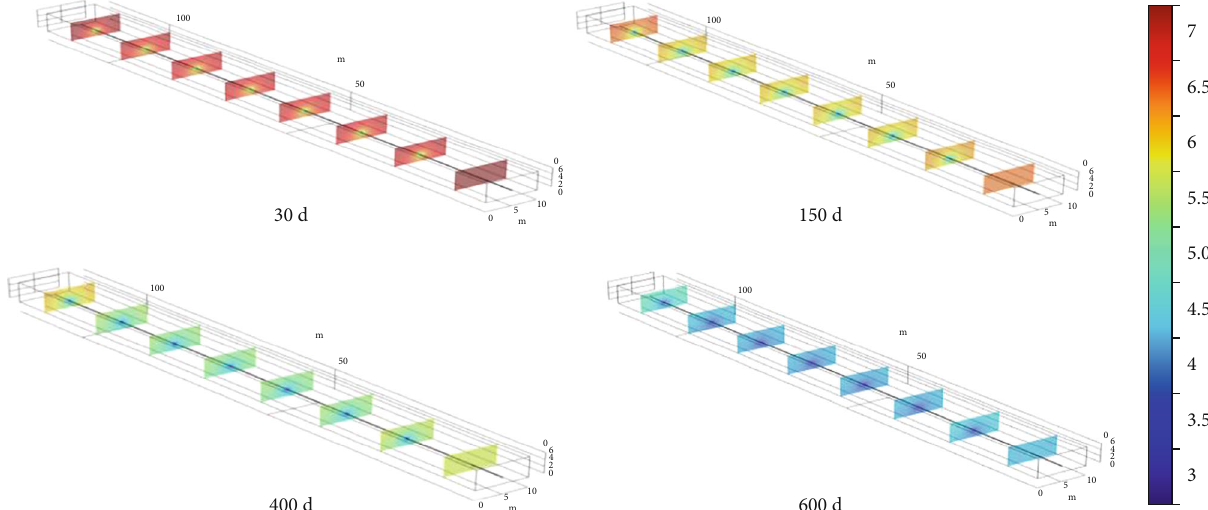
Figure 7: Vertical section diagram of gas content distribution in coal seam with